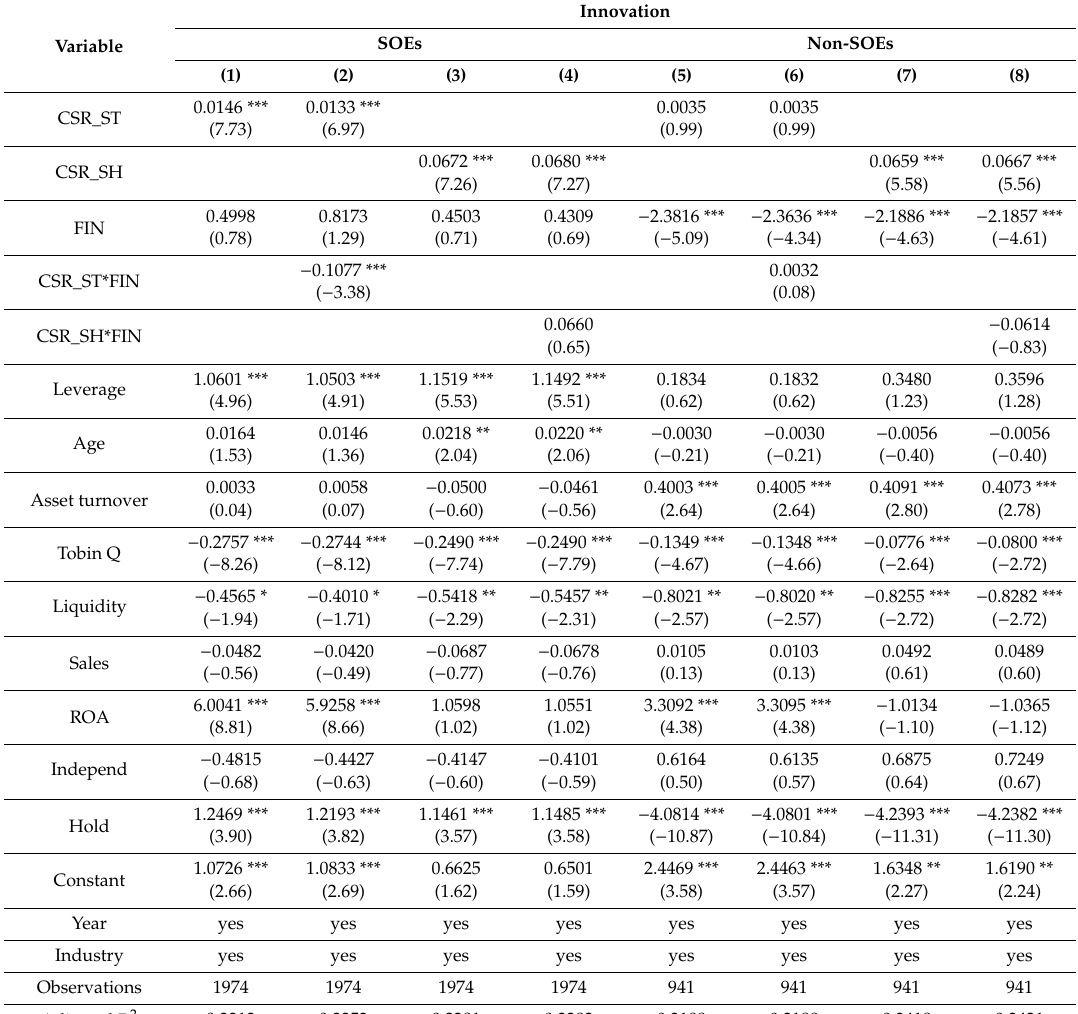
Table 9. Di ff erent CSR activities of SOEs and